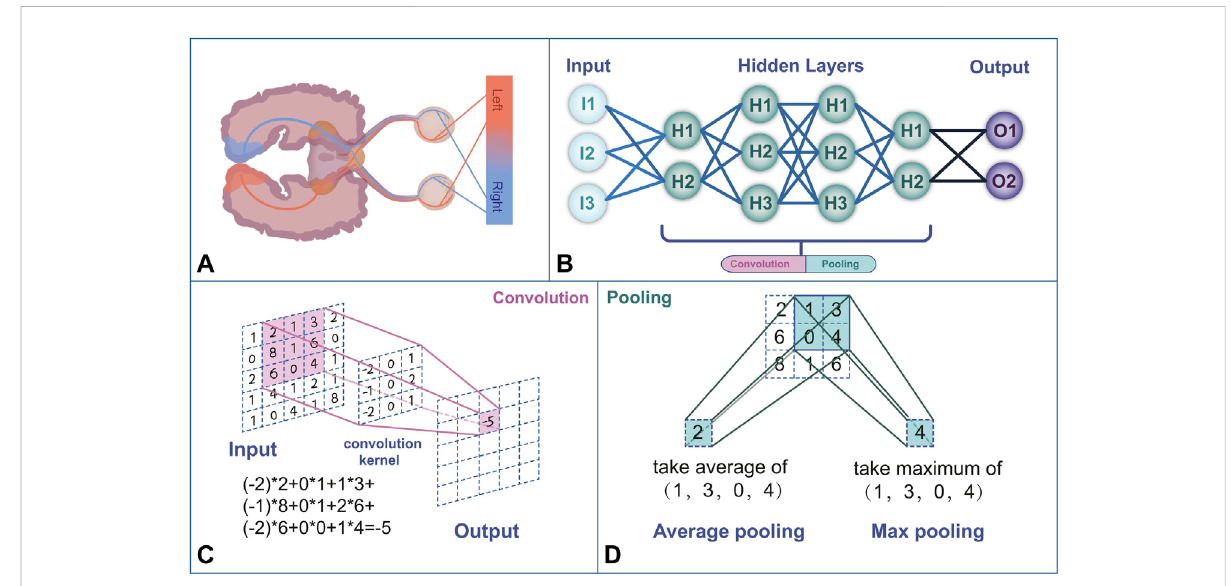
FIGURE 1 (A) Human visual feedback pathway. (B) Neural network structure framework mimics the human neural network. (C) The convolution process performs a linear transformation at each position of the image and maps it to a new value. (D) Pooling is a computational process that reduces the data size. The commonly used pooling methods are max pooling and average pooling.